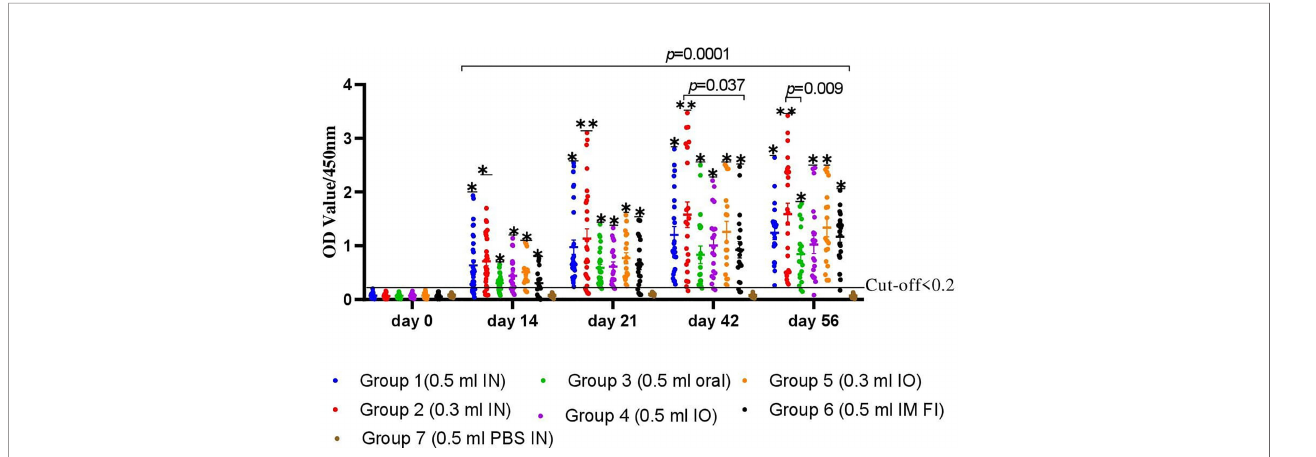
FIGURE 4 | A total of 220 chickens were assigned into seven groups: G-1 to G-5 based on the dose of candidate gamma-irradiated FC vaccine they received and the route of administration. Chickens in both G-1 and G-2 received the vaccine by intranasal route at a dose of 0.5 and 0.3 ml, respectively. Similarly, chickens in